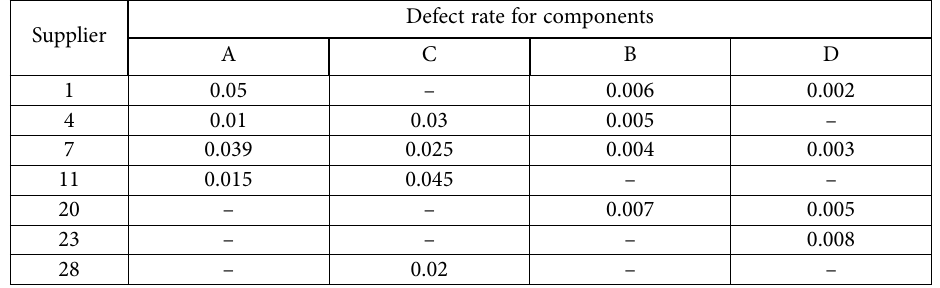
Table 31. Defect rate for the components A–D